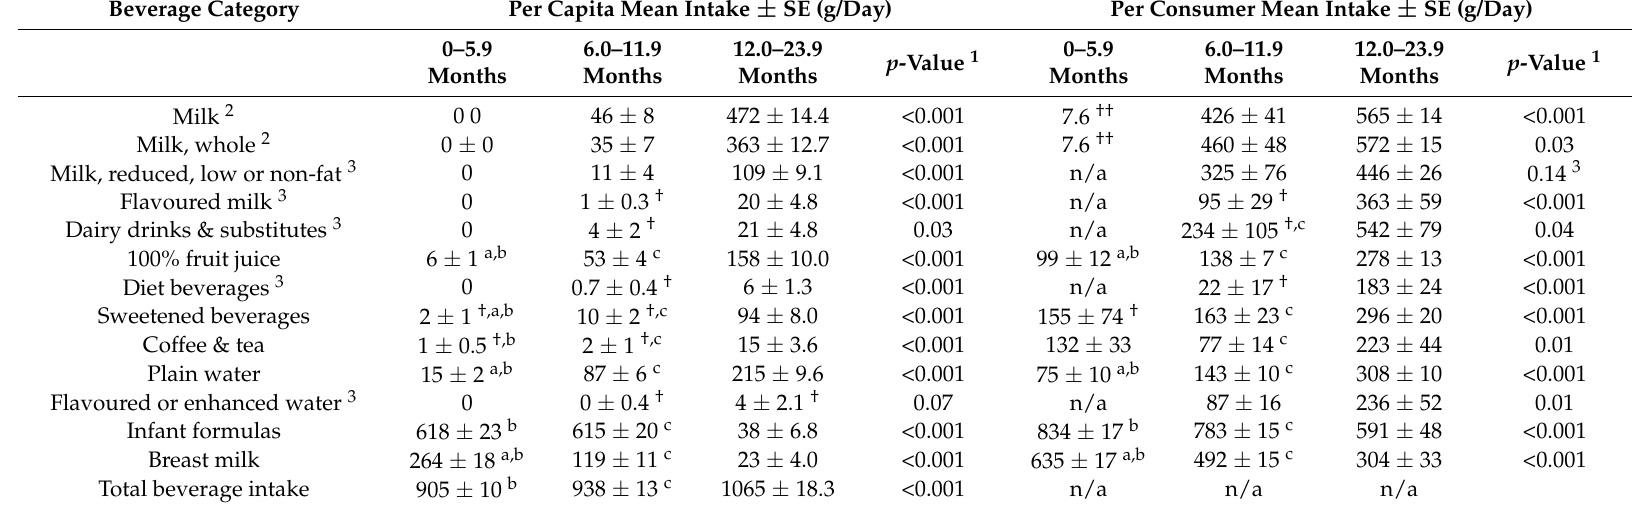
Table 1. Beverage consumption by age group ( n =